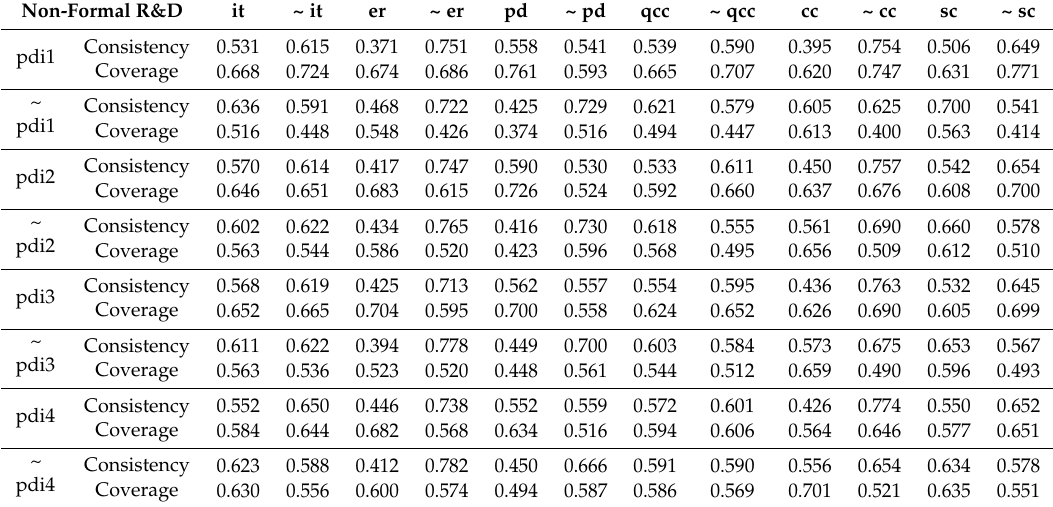
Table 5. Necessity conditions analysis for non-formal R&D